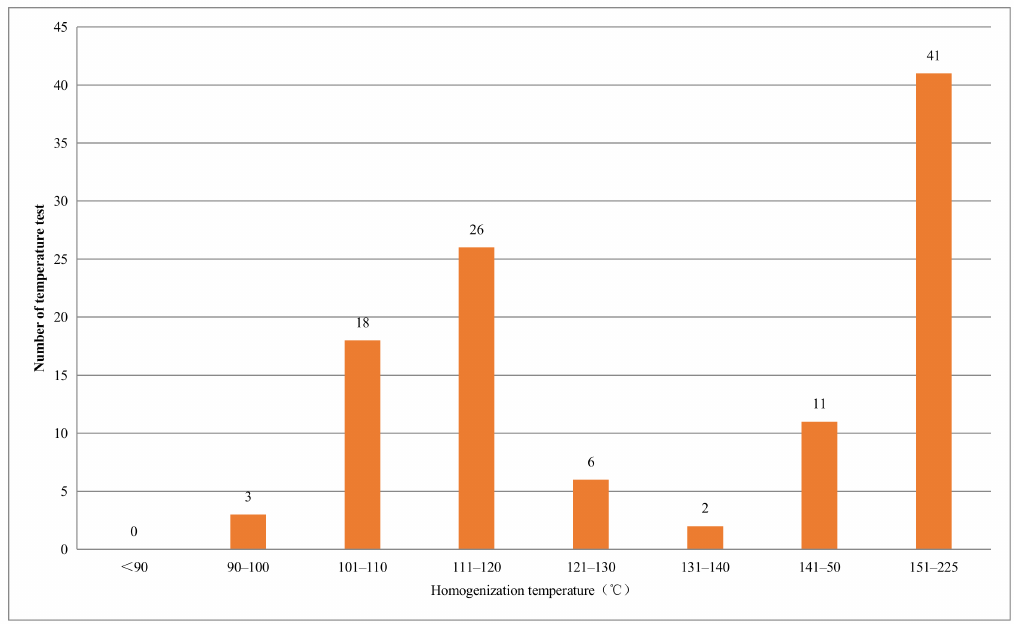
Figure 9. Temperature distribution range of chemical fillings in deep fracture-cavity of Huanjiang